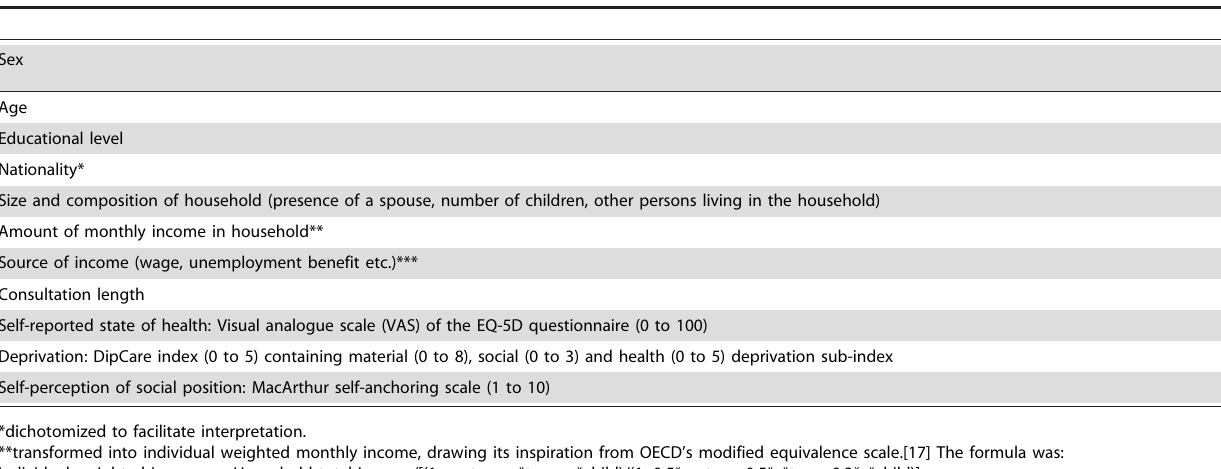
Table 1. Potential patient level correlates of GPs’ perception of patient social status.